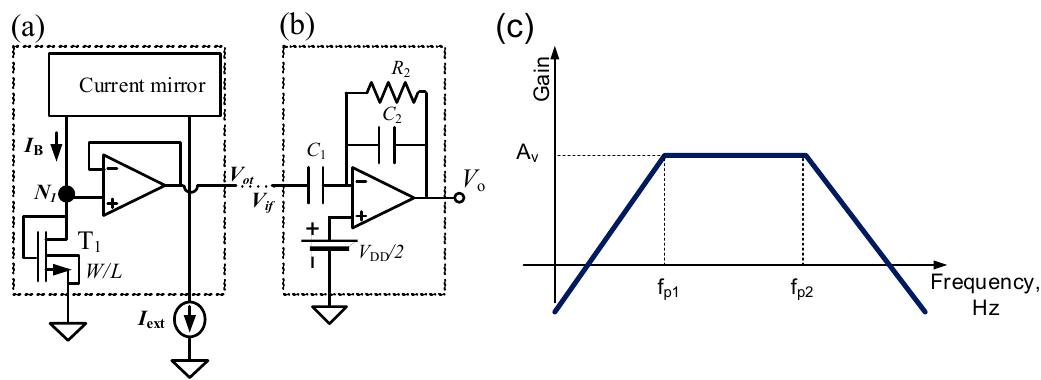
Figure 2. Temperature sensor schematic. ( a ) Temperature transducer based on an nMOS transistor (T 1 ). ( b ) Active band pass filter (BPF). In our design: I ext is off-chip. ( c ) Typical BPF frequency response of the circuit in ( b ), characterized by the low-frequency ( f p 1 ) pole, the high-frequency ( f p 2 ) pole and the band-pass gain A v .